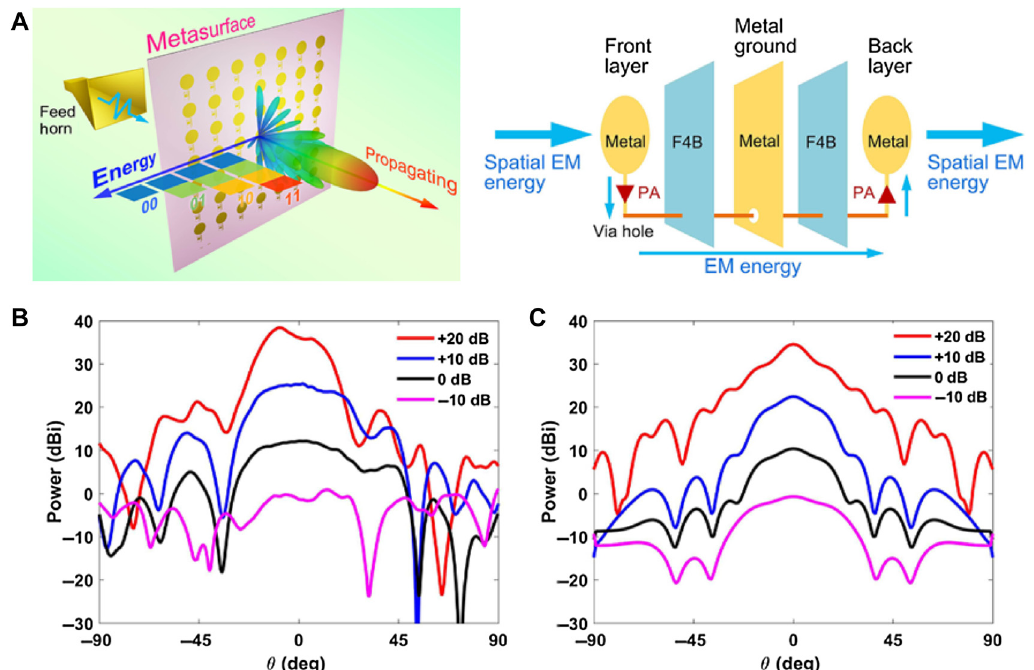
Figure 14: Digital-coding amplifying metasurface. (A) The digital-coding metasurface with active amplifiers. (B) The simulated and measured far-field results of the designed metasurface with different amplification levels [97]. Reprinted from [97], with the permission of American Physical Society